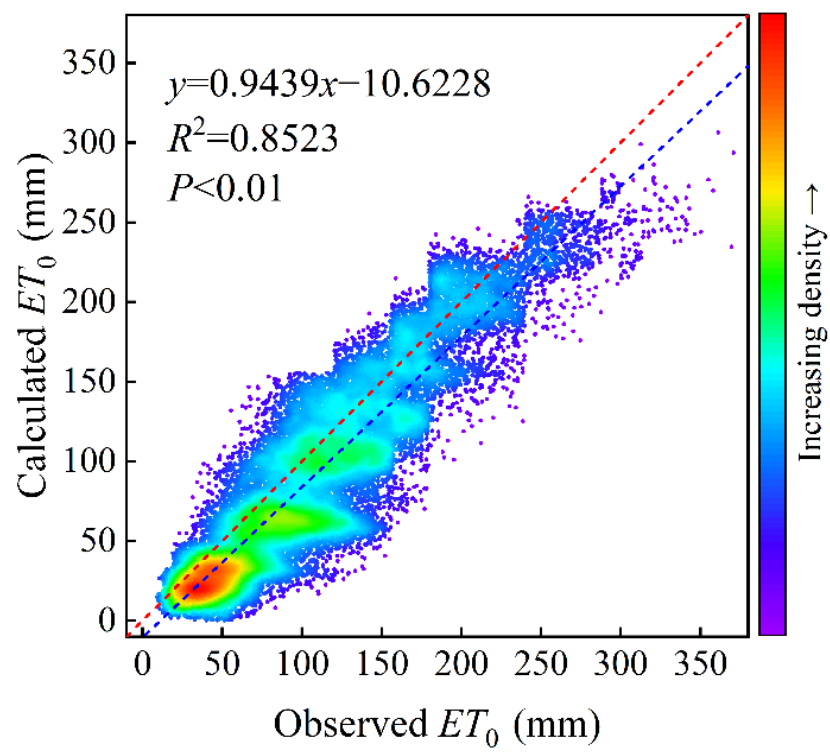
Figure 7. Scatter density plot of monthly observed pan evaporation converted values ( ET 0( pan ) ) and multi-model ensemble simulations ( ET 0( Har ) ) in the Yellow River Basin from 1980 to 2014.